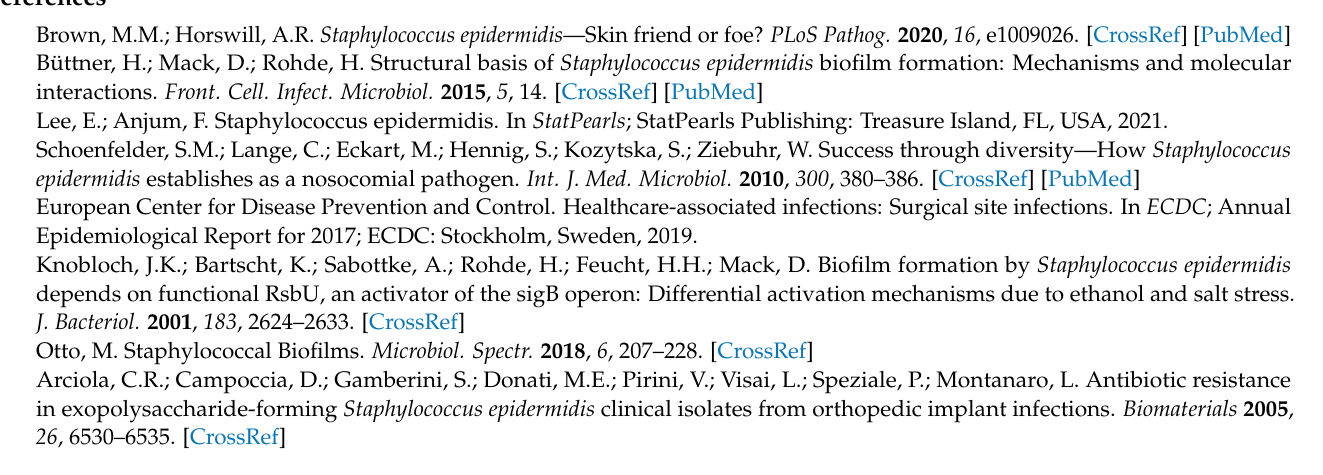
amplification. Figure S1: Cell aggregation properties of the S. epidermidis clinical isolates. Figure S2: Relationships between the antibiotic susceptibility and isolation source among the S. epidermidis clinical strains. Figure S3: Relationships between the antibiotic susceptibility and biofilm formation among the S. epidermidis clinical strains. Table S2: Generalized linear model (GLM)